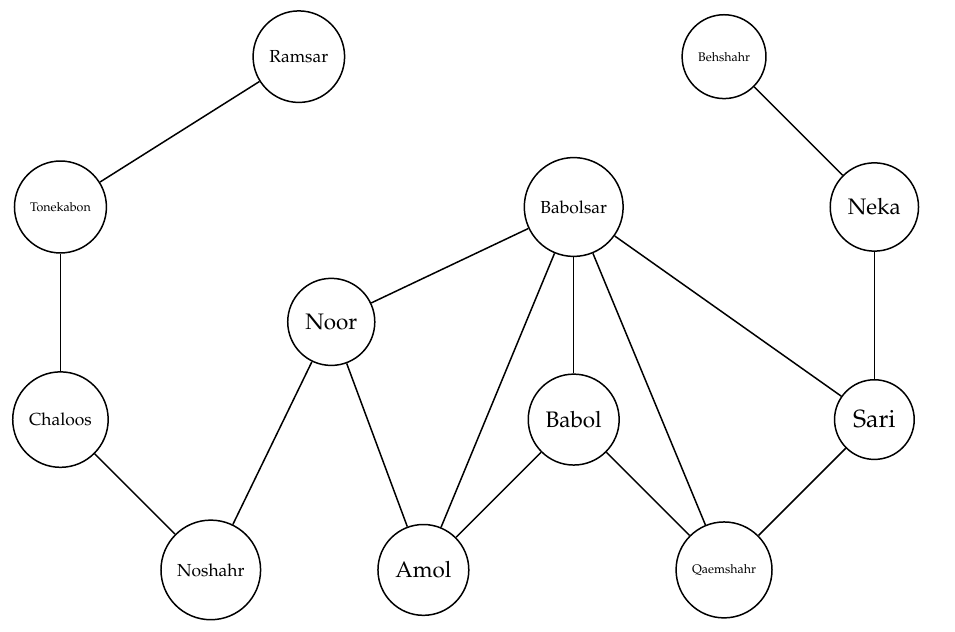
Figure 13. CG of cities.